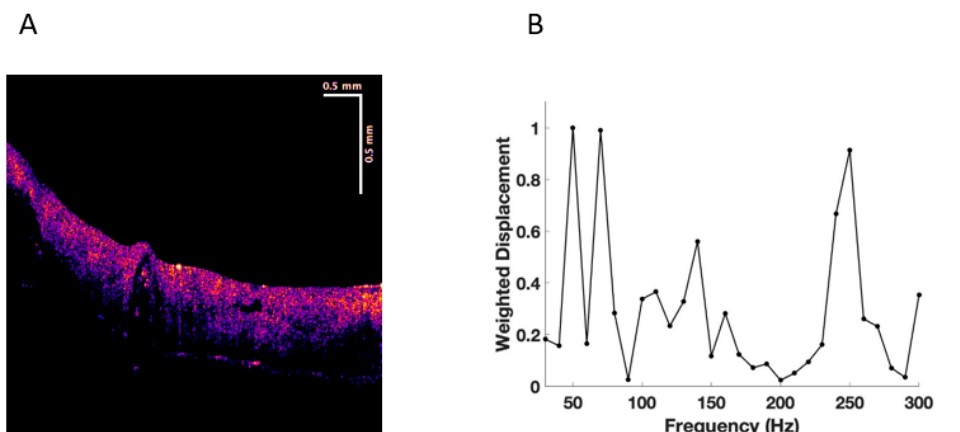
Figure 3. ( A ) Color-coded OCT image of a squamous cell carcinoma (SCC) showing the paucity of epidermis (yellow and pink) and the papillary dermis in blue. Note: the black spots are the location of the lesions. ( B ) Plot of weighted displacement versus frequency for SCC showing the new cellular (80 Hz), new vascular peak (130 Hz), and large fibrotic peak (250–260 Hz).